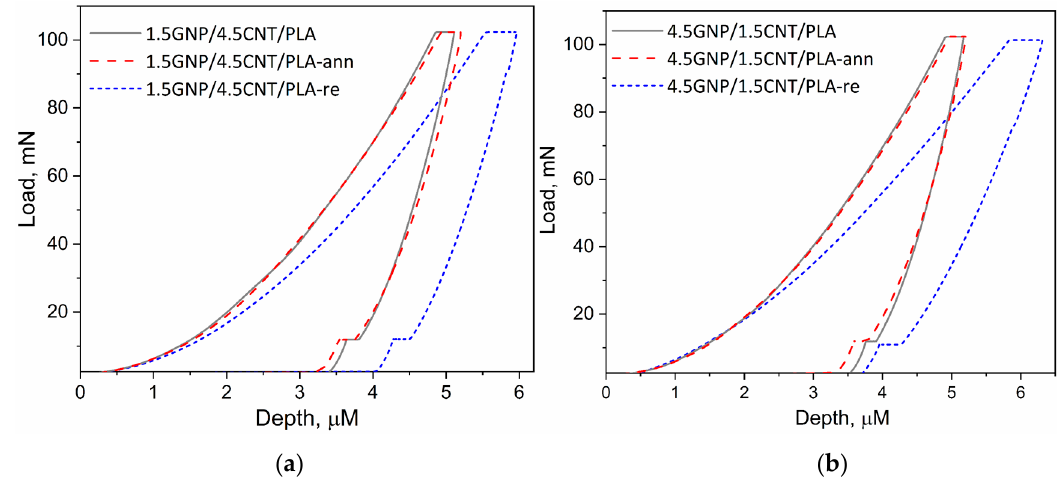
Figure 7. Nanoindentation load depth curves of aged bi-filler composite films, 1.5GNP / 4.5CNT / PLA ( a ) and 4.5GNP / 1.5CNT / PLA ( b ), comparing the control sample, the solid-annealed films (at 80 ◦ C for 4 h), and the melt-reprocessed films (at 200 ◦ C). Table 3. Nanoindentation hardness and Young’s modulus and the crystallinity ( χ c ,.%) of the aged films after 18 months of storage (control) compared to the “annealed” and the “melt-reprocessed” aged films. Aged Films after